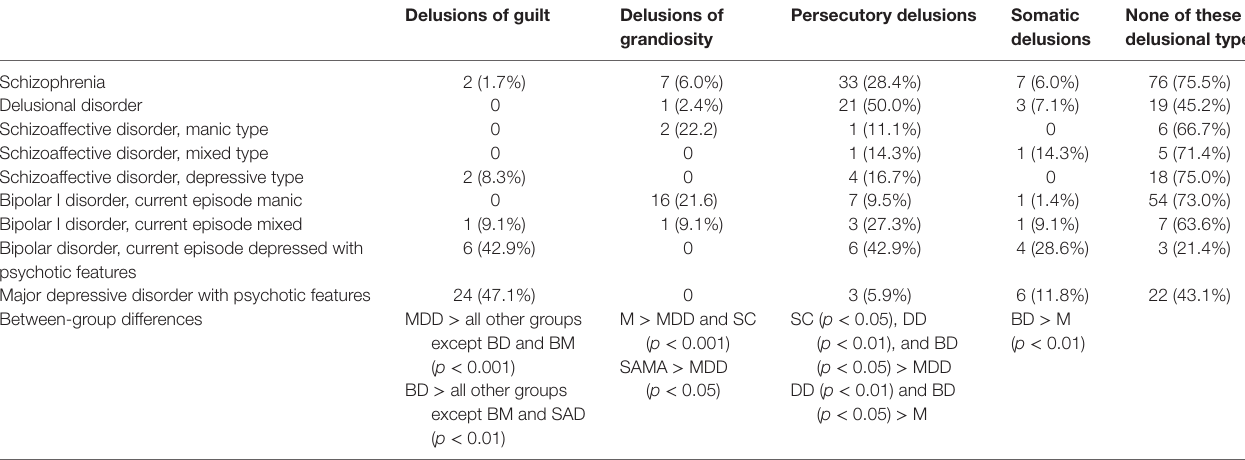
Table 3 | Presence of specific delusional themes by diagnostic group in patients diagnosed with the SCID-I ( N =